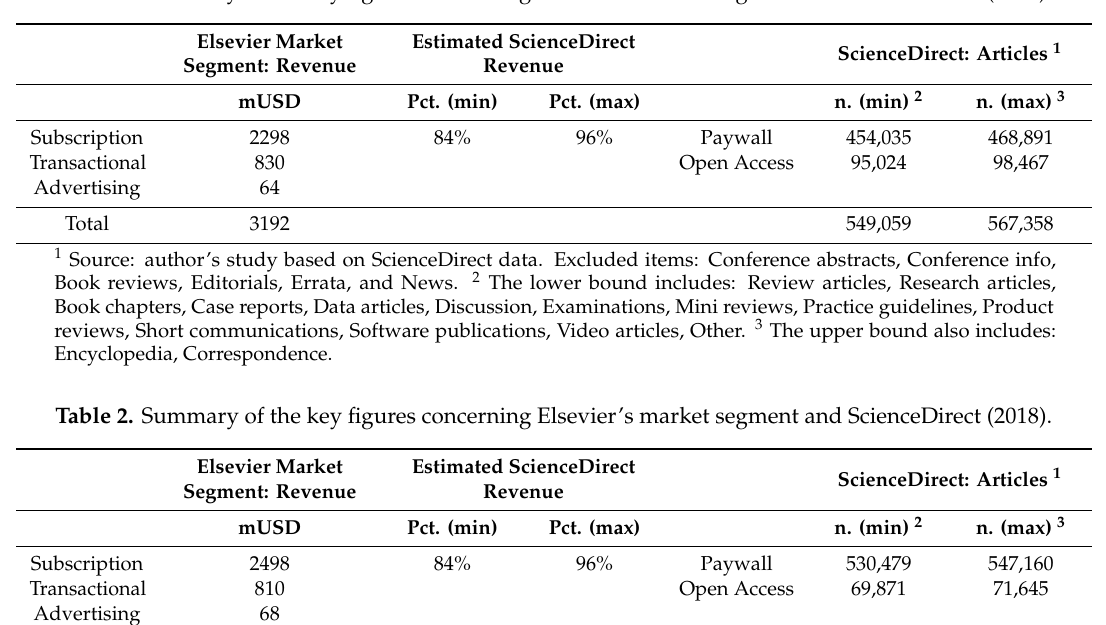
Table 1. Summary of the key figures concerning Elsevier’s market segment and ScienceDirect (2017).